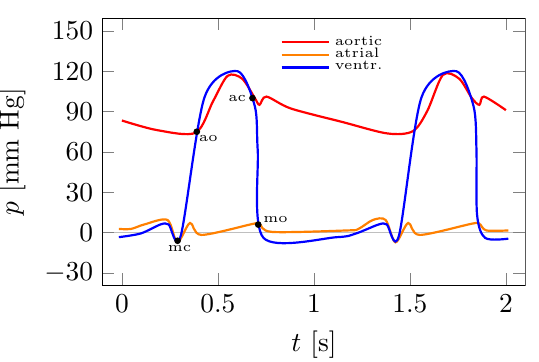
Figure 6. Reference Wiggers diagram: mo—mitral valve opening, ao—aortic valve opening, mc— mitral valve closure, ac—aortic valve closure.